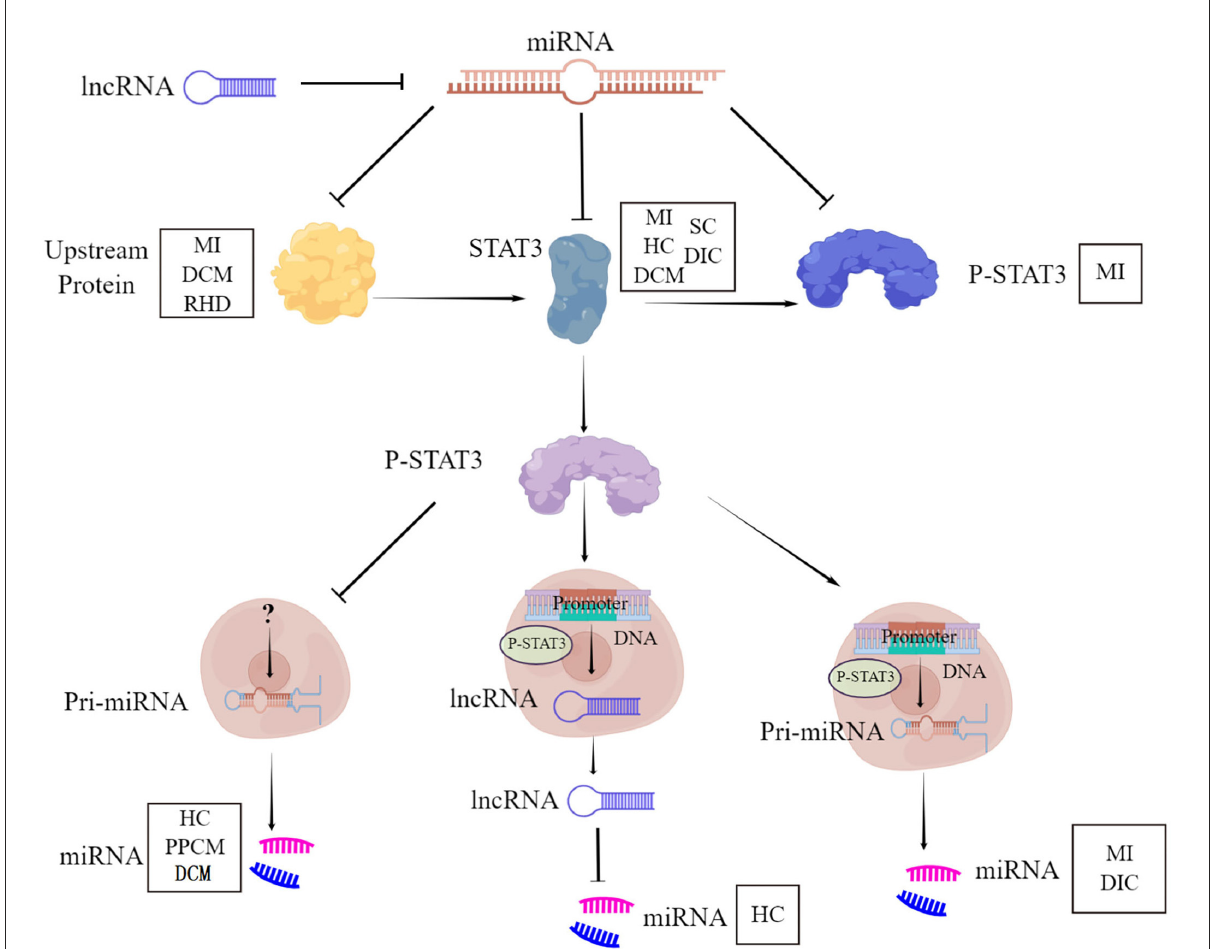
FIGURE1 STAT3-miRNA crosstalk. STAT3, Signal Transducer and Activator of Transcription 3; P-STAT3, phosphorylation of STAT3; miRNA, MicroRNA; lncRNA, Long non-coding RNA; MI, Myocardial infarction; DCM, Dilated cardiomyopathy; RHD, Rheumatic heart disease; HC, Hypertrophic cardiomyopathy; SC, Septic cardiomyopathy; DIC, Drug-induced cardiomyopathy; PPCM, Peripartum